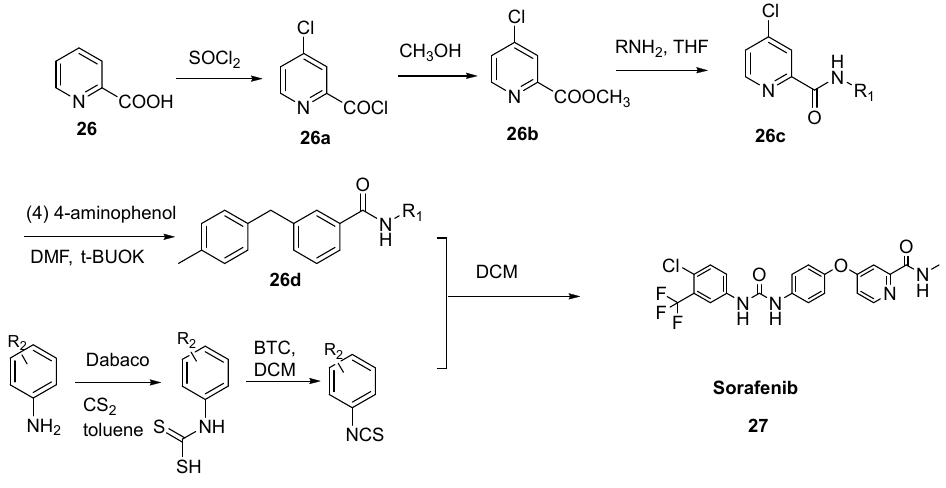
Figure 15. Synthesis and structure of sorafenib.